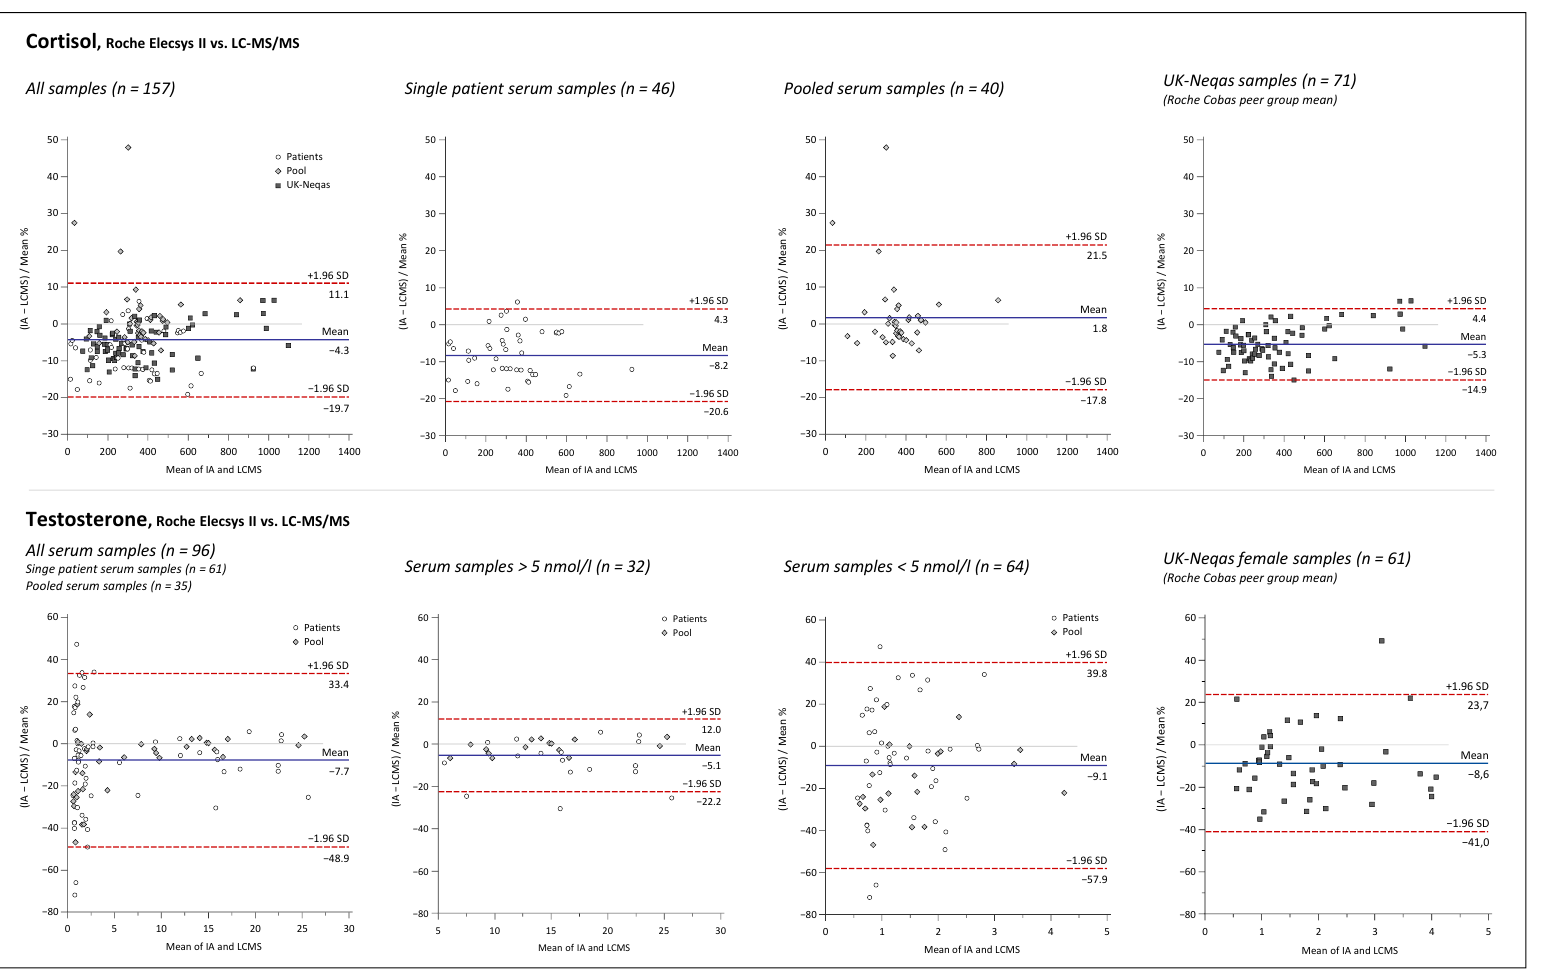
Figure 6. Bland and Altman plots comparing measurement results of the LC-MS/MS (LCMS) method and in-house immunoassays (IA) for analytes cortisol and testosterone differentiating between single patient serum samples (circles), pooled serum samples (diamonds), and UK NEQAS proficiency testing samples (squares). x -axis: mean of IA and LC-MS results in nmol/L; y -axis: difference between both measurements in % of the mean of both methods.